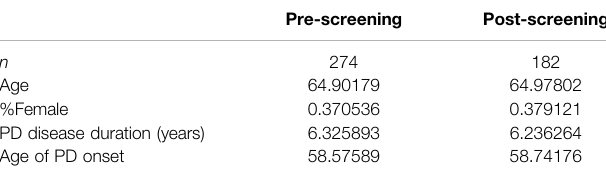
TABLE 1-0 | Pre-screening and post-screening patient demographics.